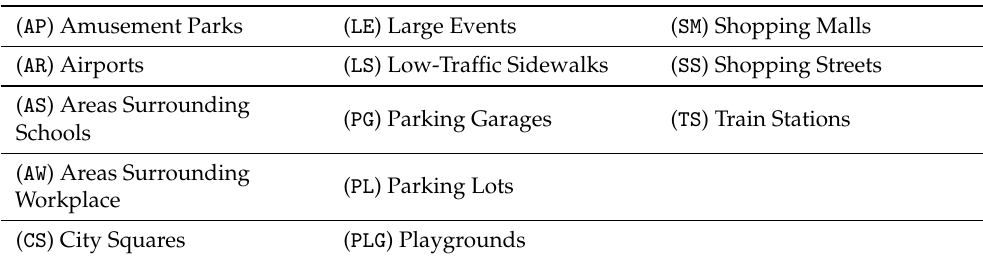
Table 1. Overview of public areas and their acronyms. The entries are shown column-wise in alphabetical